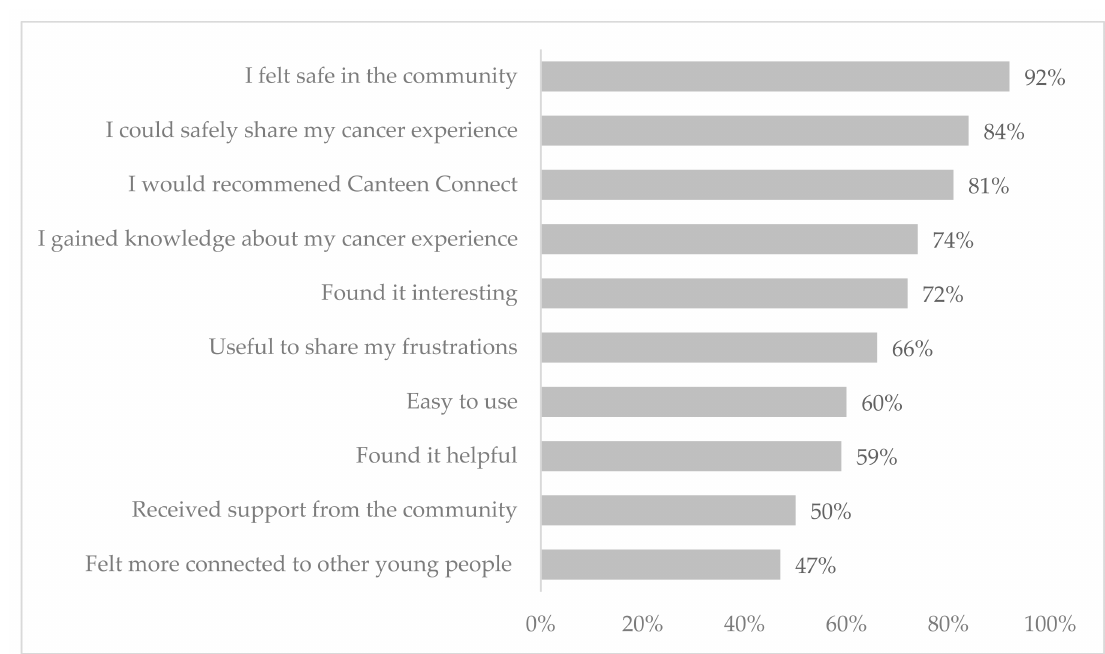
Figure 3. Acceptability of Canteen Connect version